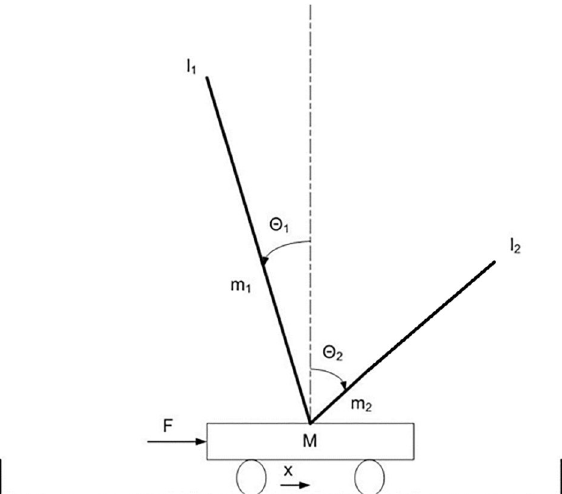
Figure 1. The long double-pole balancing problem.